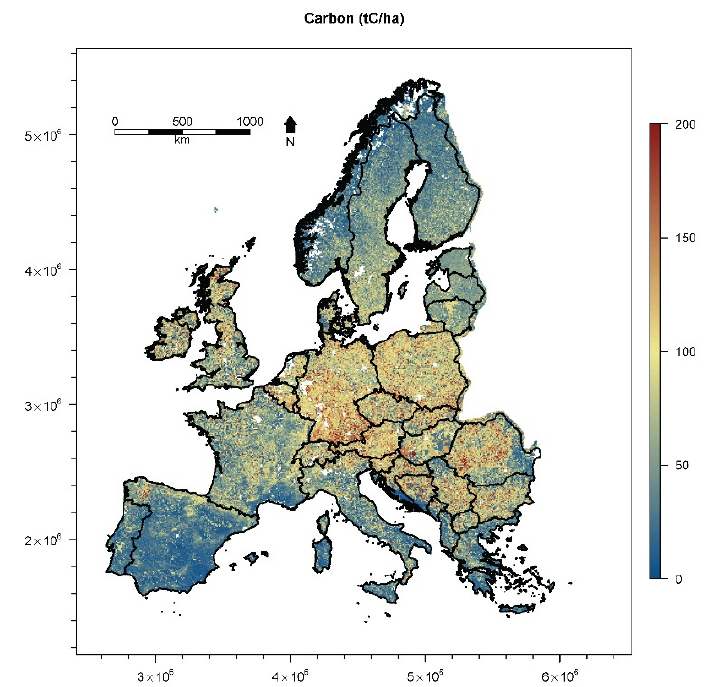
Figure 4. Mean carbon content per forested area (tC/ha) for vegetated 8 × 8 km cells. In this figure, values higher than 200 tC/ha are truncated for display reasons. For details, see Figure 3.